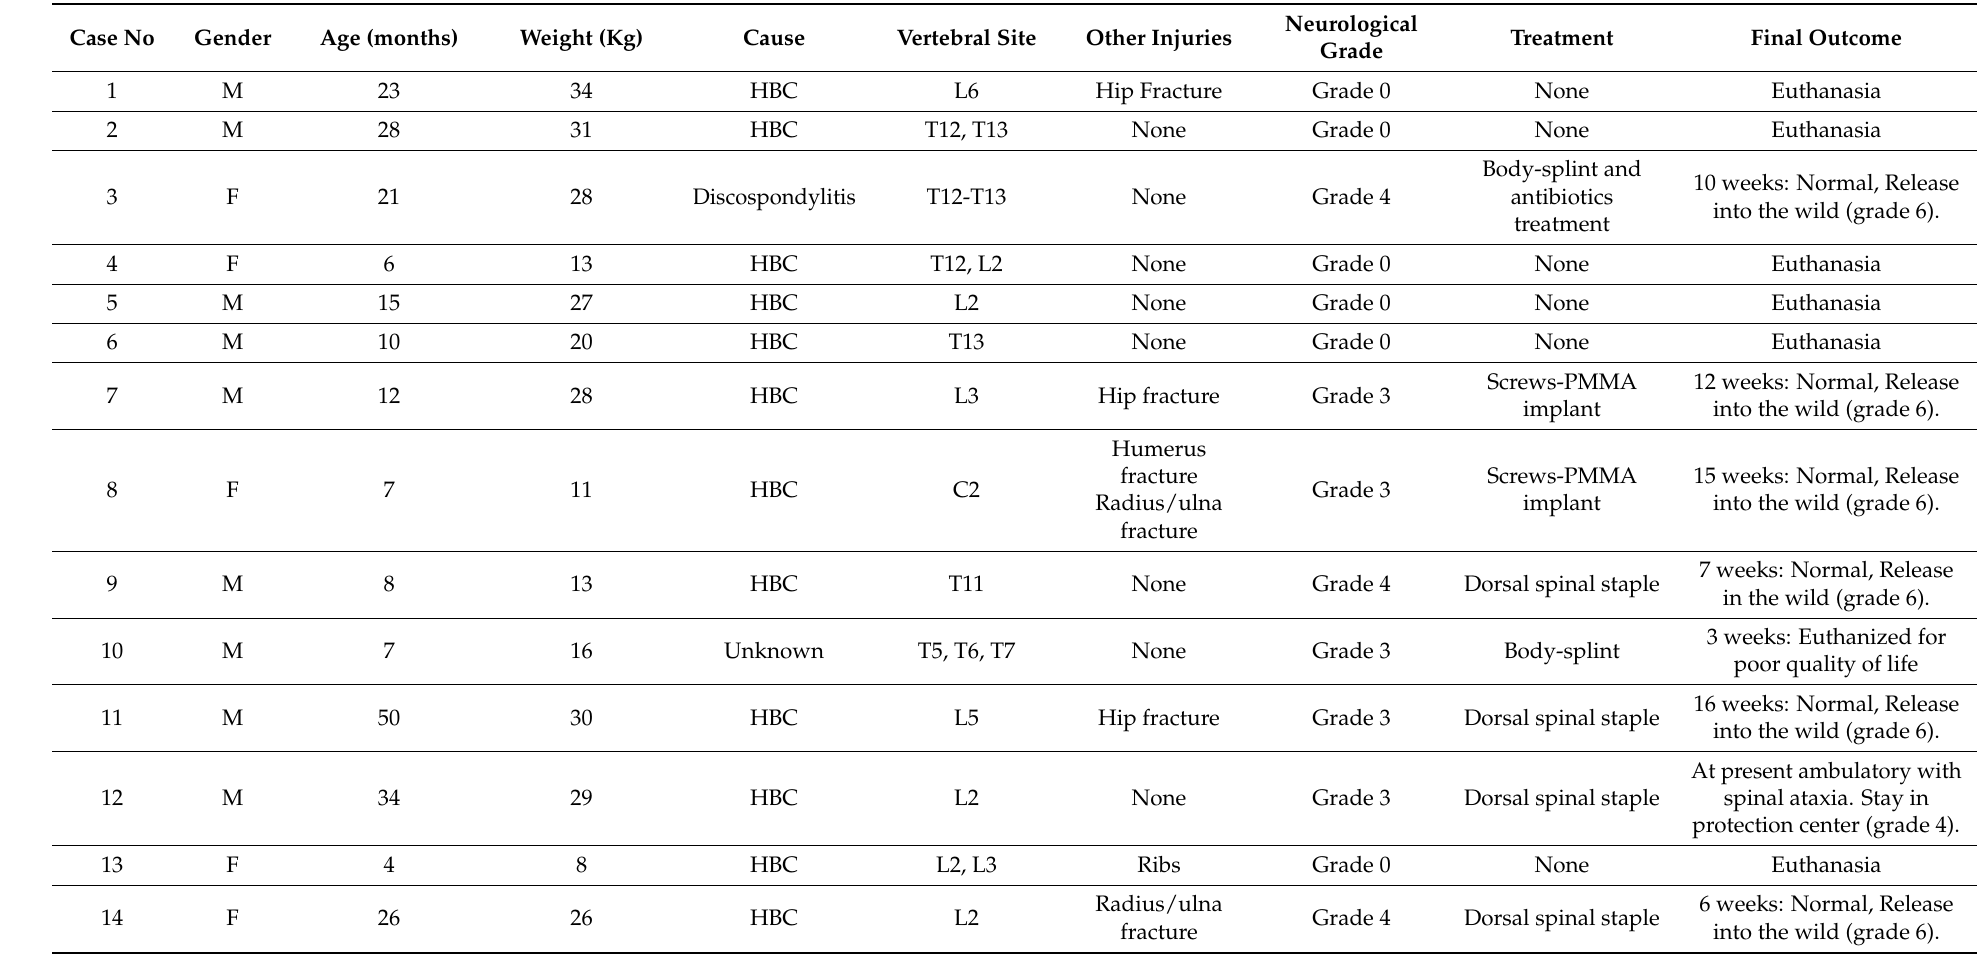
Table 1. Clinicopathological features in 14 Italian